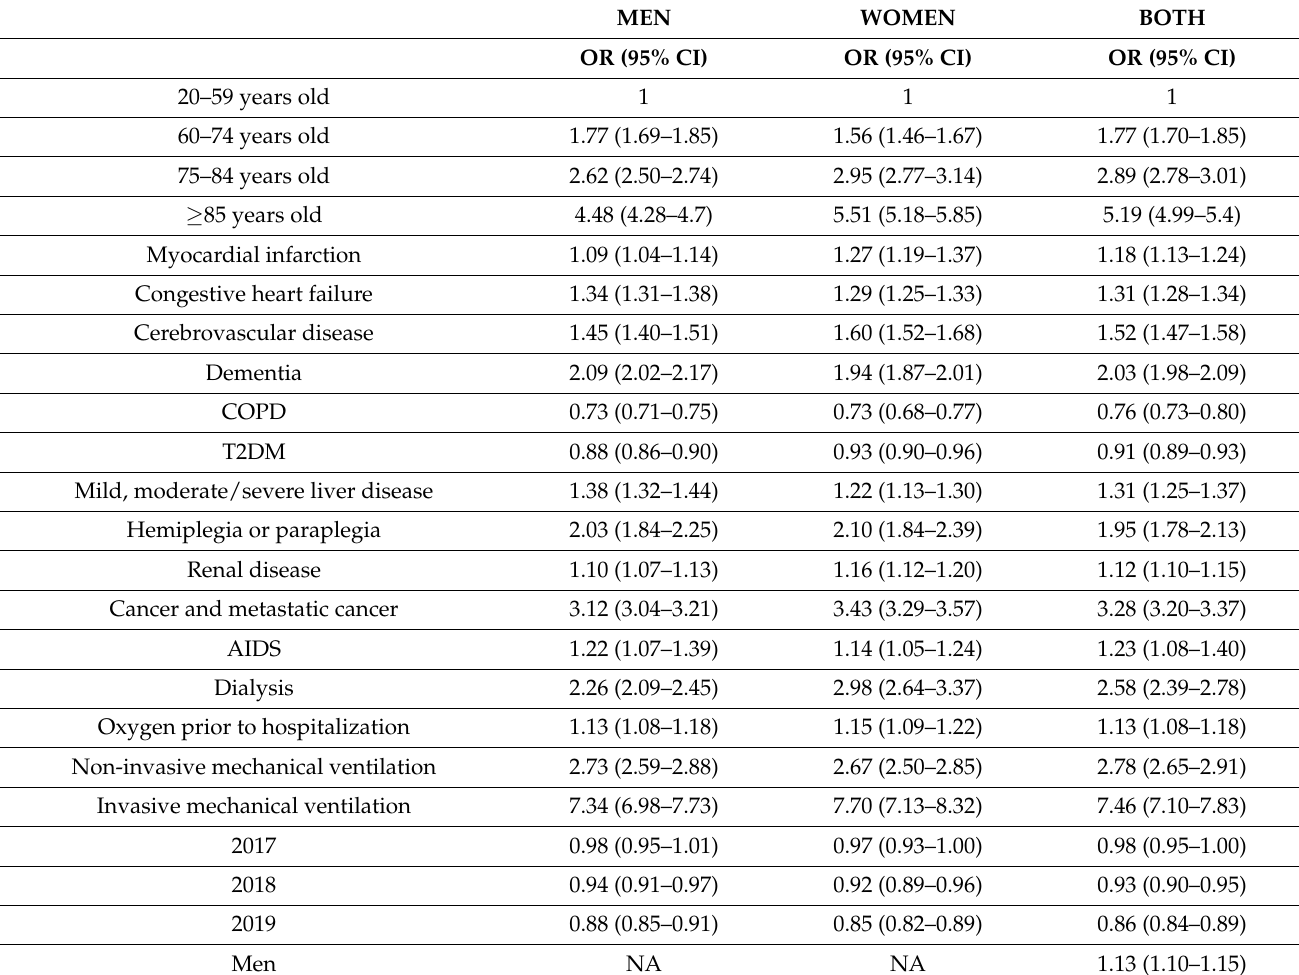
Table 5. Multivariable analysis of factors associated with in-hospital mortality during admission for community-acquired pneumonia (CAP), according to